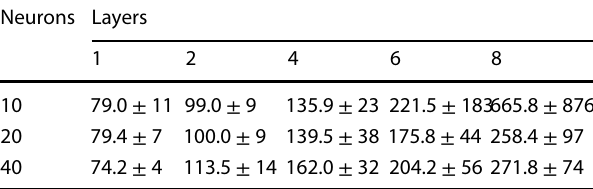
Table 5 Section 5.2: CPU times (in seconds) for 10 independent runs of the proposed neural network approach applied to the Pois- son problem with analytical primal and adjoint solution. We com- pare various number of hidden layers and the number of neurons therein Neurons Layers